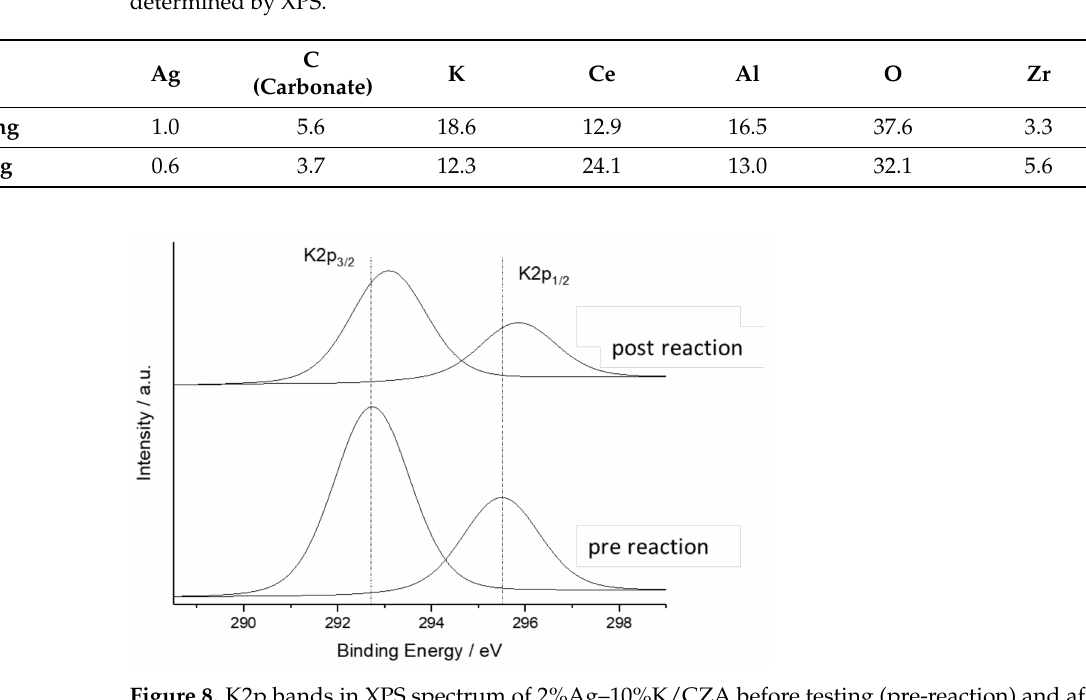
Table 1. Surface composition of 2%Ag–10%K/CZA before and after testing in absence of soot, as determined by XPS.